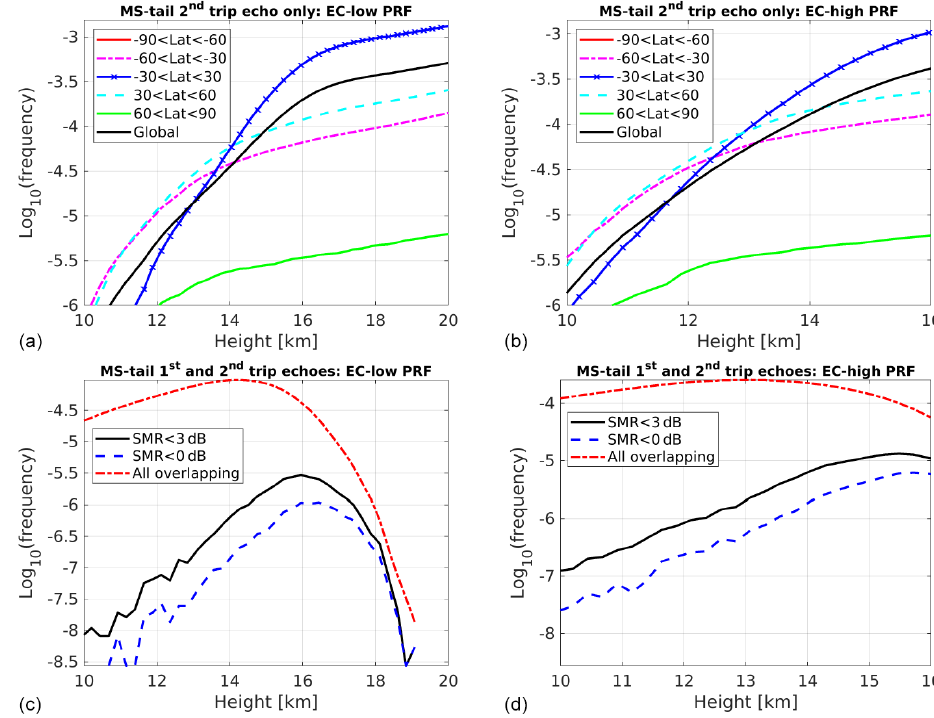
Figure 11. Same as Fig. 9 for the second-trip echoes generated by MS